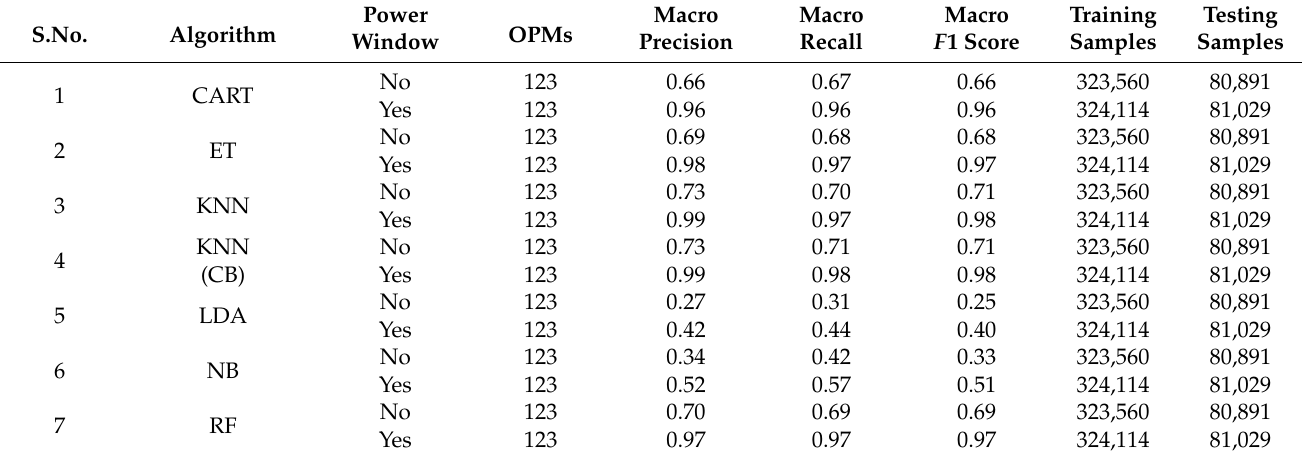
Table 4. Performance of the trained machine learning